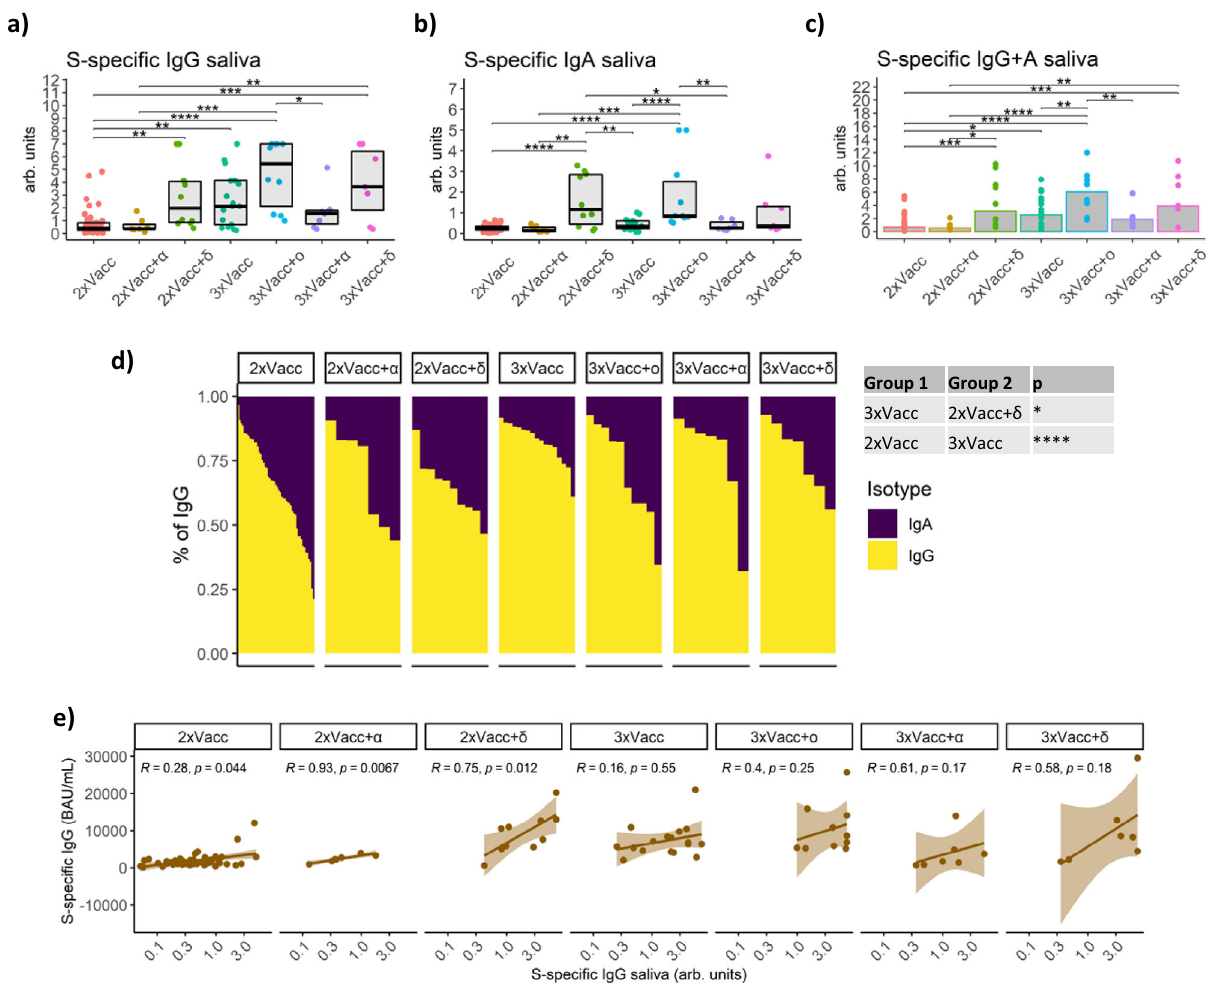
Fig. 2 | SARS-CoV-2-speci fi c antibodies in saliva. S1-speci fi c a IgG (exact p values insequentialorderfromtheupmostbracket:** p =0.0091,*** p =0.0003,* p =0.015, *** p <0.00012, **** p <0.0001, ** p =0.0032, ** p =0.0091), b IgA (exact p values in sequential order from the upmost bracket: ** p =0.0015, * p =0.019, **** p <0.0001, *** p <0.00027, **** p <0.0001, ** p =0.0027,** p =0.0044, **** p <0.0001),and c IgG +IgA (exact p values in sequential order from the upmost bracket: ** p =0.0098, *** p =0.00041, ** p <0.0015, ** p <0.0023, **** p <0.0001, * * ** p <0.0001, * p <0.017, * p <0.016, *** p <0.00034) levels in saliva for the seven groups with different anti- gen exposure histories. Data is displayed as boxplots ( a , b ), indicating the fi rst quartile,median, and thirdquartile, orbarsshowing the median ( c )withindividual data points. d Relative proportions of IgA and IgG isotypes among the S1-speci fi c antibodies in the saliva of individuals with different antigen exposure histories.